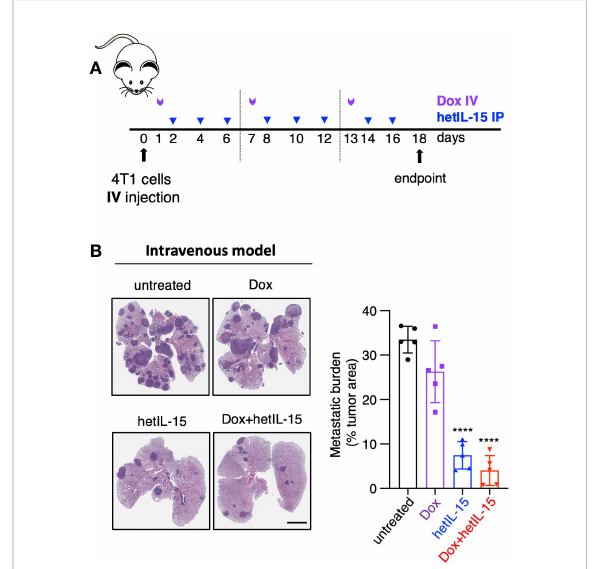
FIGURE 2 hetIL-15 alone and in combination with doxorubicin exerts local anti-metastatic effect in the lungs. (A) Cartoon showing the treatment design. 10 4 4T1 cells were injected IV in Balb/c mice and the animals were randomized in four groups: (i) untreated (PBS), (iii) Dox-treated, (iii) hetIL-15-treated and (iv) Dox+hetIL- 15-treated. Treatment started one day post tumor cell injection with Dox (5mg/kg IV, purple arrows) once per week, followed by hetIL-15 (3 m g/mouse IP, blue arrows) every other day until day 16. (B) Representative images of H&E-stained lung sections (left panel) and the metastatic burden expressed as percentage of tumor area (right panel) in each group on day 18. Percentages presented as mean ± SD for each group. Scale bar, 4mm. Results are from one experiment (n= 5). Statistical analysis was done by one-way ANOVA and Tukey ’ s multiple comparisons test. Asterisks show the signi fi cance of difference from the untreated group, **** p < 0.0001. Image Credit: